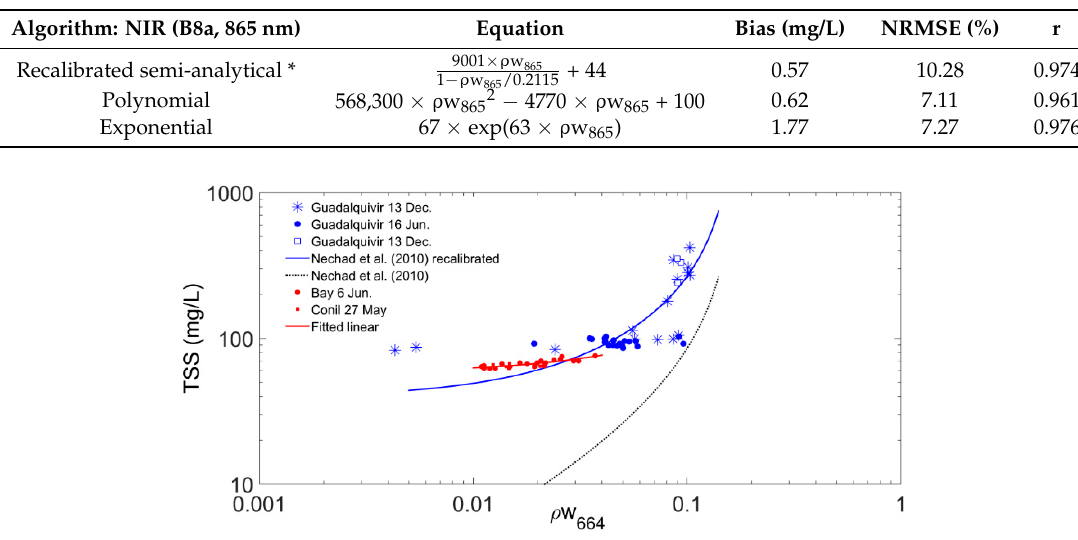
Figure 4. Relationship for Total Suspended Solids (TSS) retrieval in the Guadalquivir estuary based on the recalibrated reflectance model [29] using the red band (B4) at 664 nm (blue line, logarithmic scales). Black dashed line represents the original fit at this wavelength. Linear fit obtained in Cadiz Bay and Conil port with the red band is presented (red line).